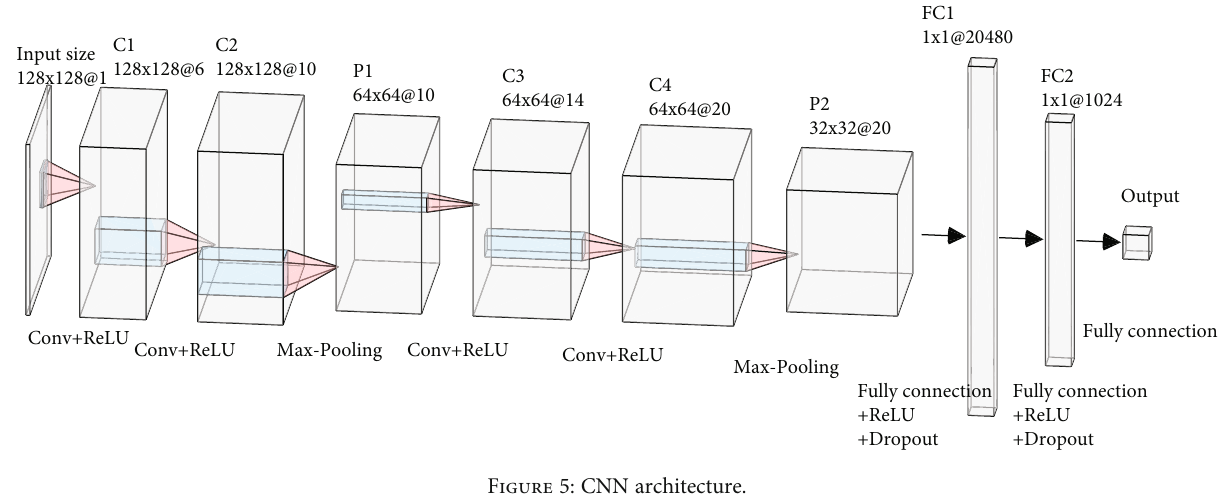
Figure 5: CNN architecture.